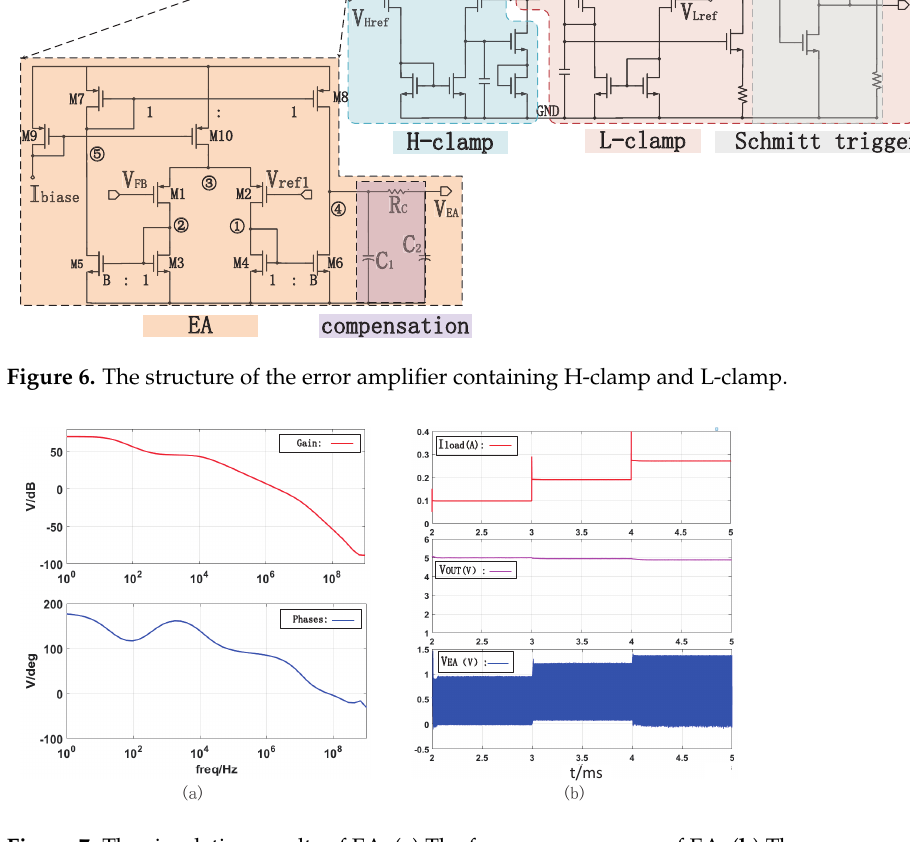
Figure 7. The simulation results of EA. ( a ) The frequency response of EA. ( b ) The correspondence of I load , V OUT , and V EA